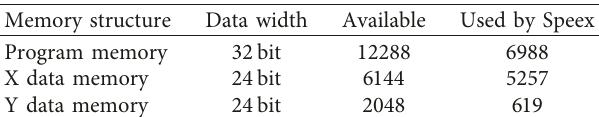
Table 3: Memory requirements of Speex (submodes 3 and 4) in Belasigna 300.